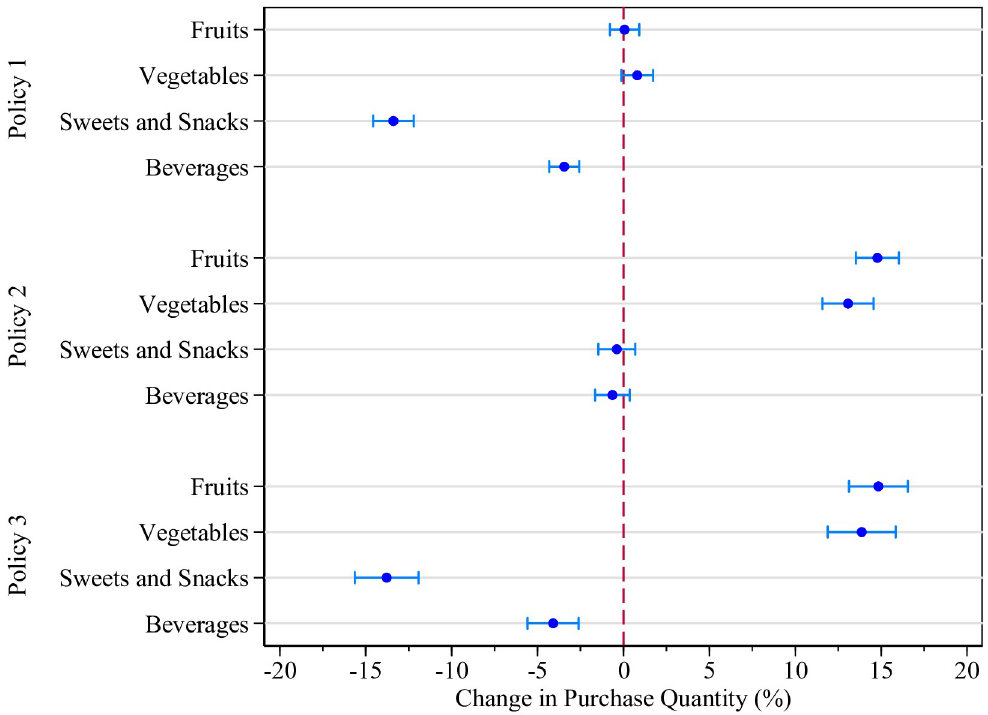
Fig 1. Average percentage change in household purchases (%). Notes: Results are shown only for food/beverage groups targeted by taxes or subsidies. All point estimates are accompanied by a 95% confidence interval calculated using bootstrapped standard